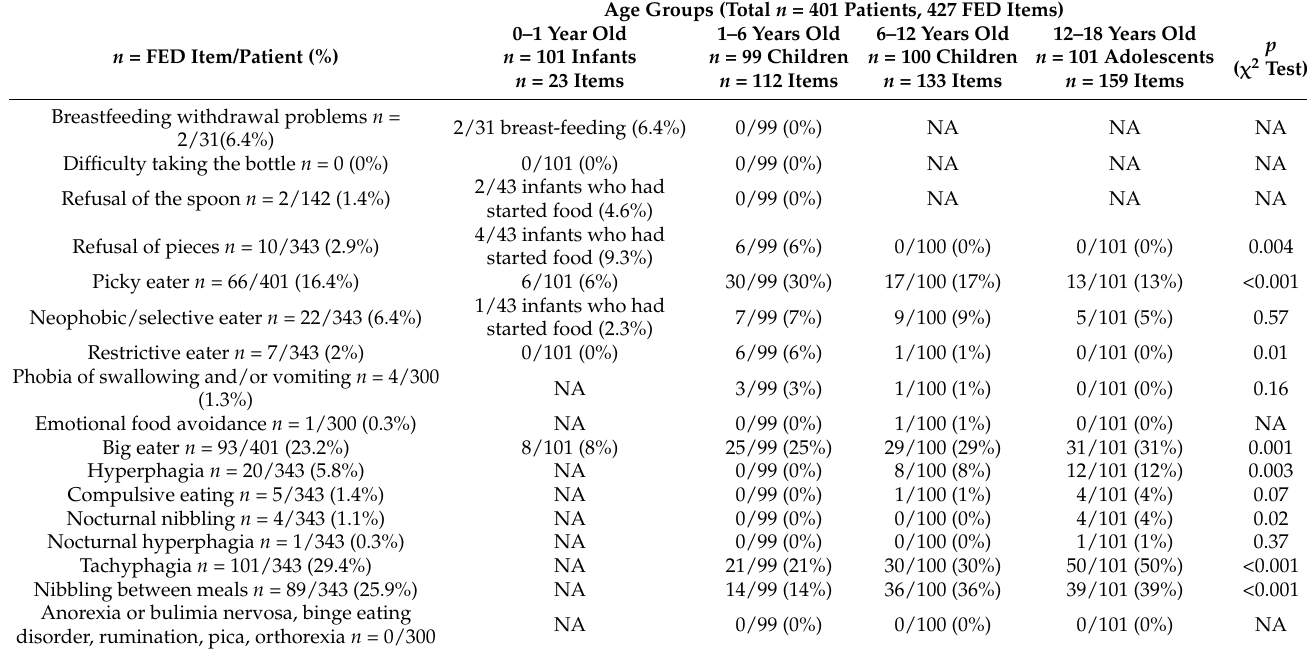
Table 2. Prevalence of feeding and eating disorders (FED) items by age